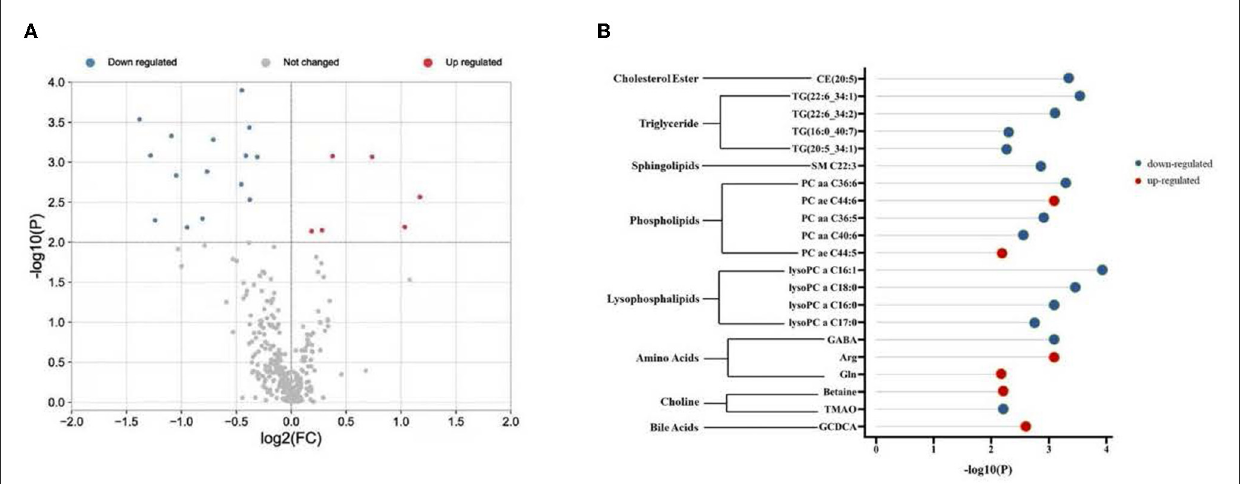
FIGURE1 Different metabolites in two groups. (A) Volcano plot shows -log 10 P against the log 2 -fold change of 311 metabolites in the high exposure group vs. the low exposure group. Blue denotes down-regulated metabolites, red denotes up-regulated metabolites, and gray denotes no change. (B) Twenty-one differentially regulated metabolites were associated with PM 2.5 exposure. Red indicates up-regulation and blue indicates down-regulation. PM 2.5 , PM with particle diameter < 2.5 µ m; GABA, γ -aminobutyric acid; Arg, arginine; Gln, Glutamine; TMAO, trimethylamine N-oxide; GCDCA, glycochenodeoxycholic